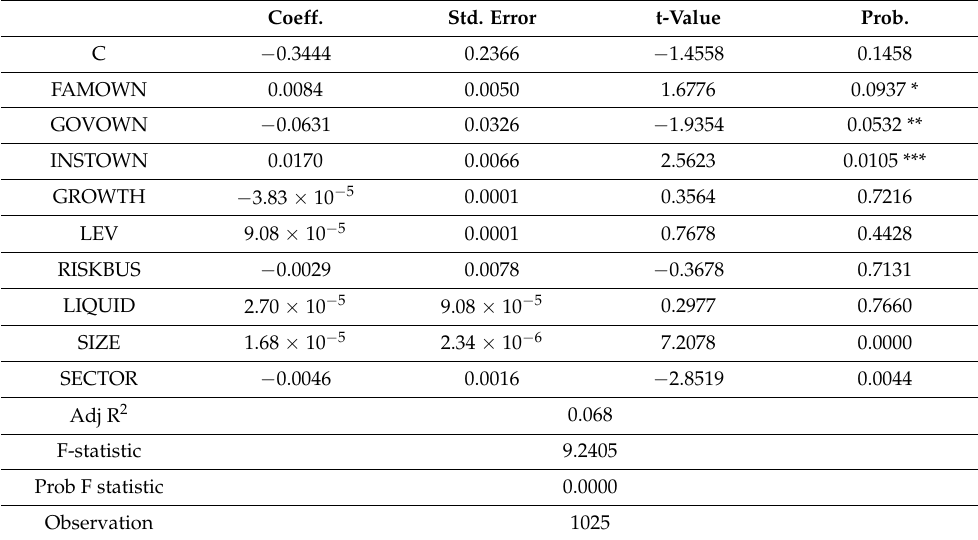
Table 6. Robustness check.